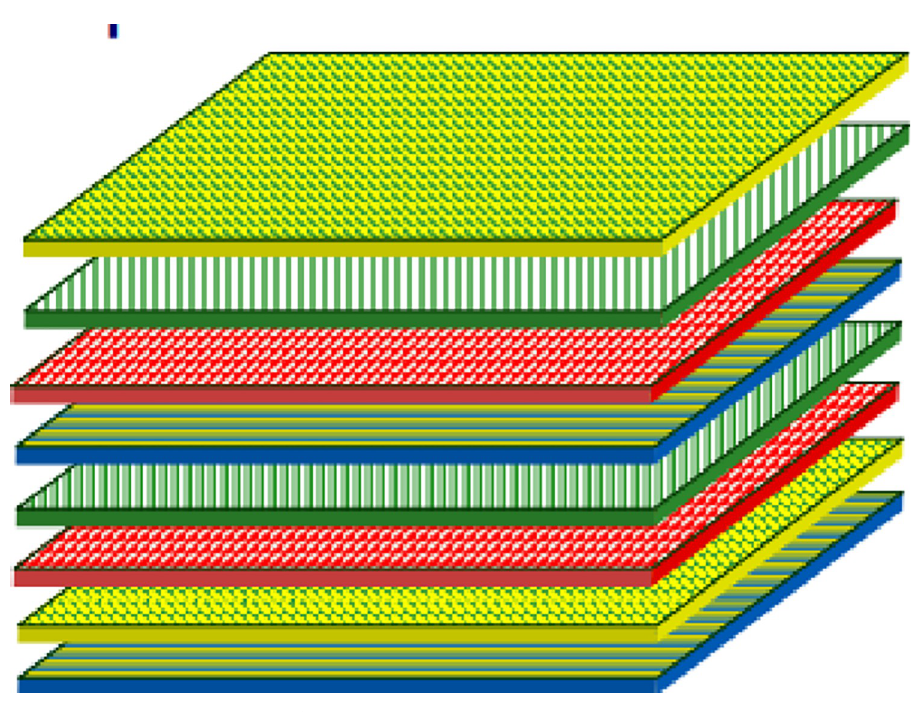
Fig 2. Laminate composite